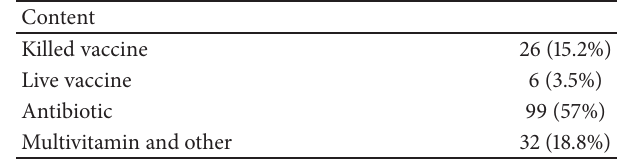
Table 5: What was contained in the syringe (𝑛 = 171) ?